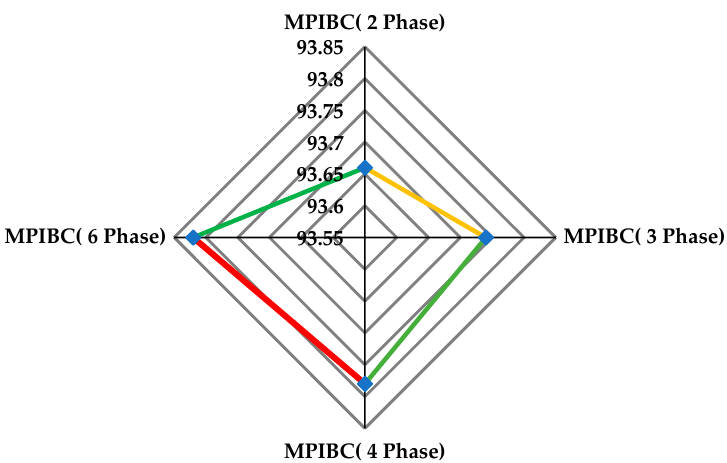
Figure 7. %Efficiency comparison of MPIBC (input voltage: 20 V).